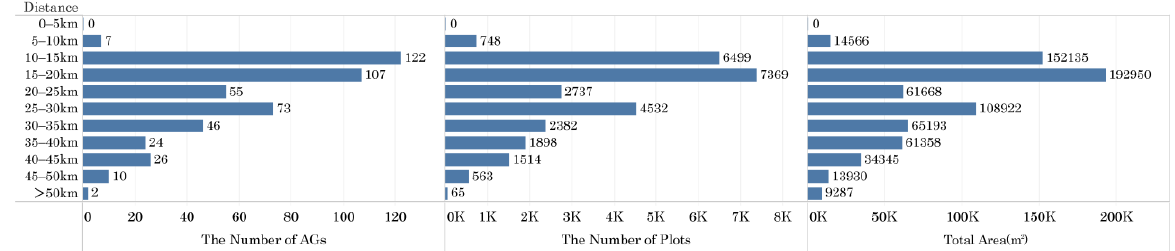
Figure 11. AGs ’ statistical data in the multi-distance zones from the center of Tokyo. Figure 11. AGs’ statistical data in the multi-distance zones from the center of